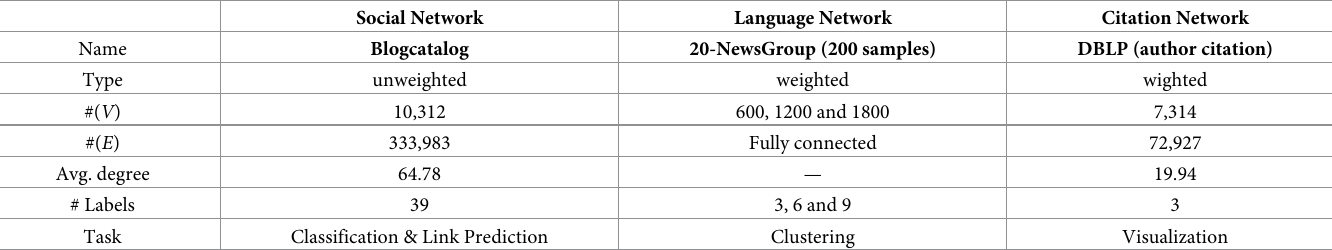
Table 1. Statistics of the real-world